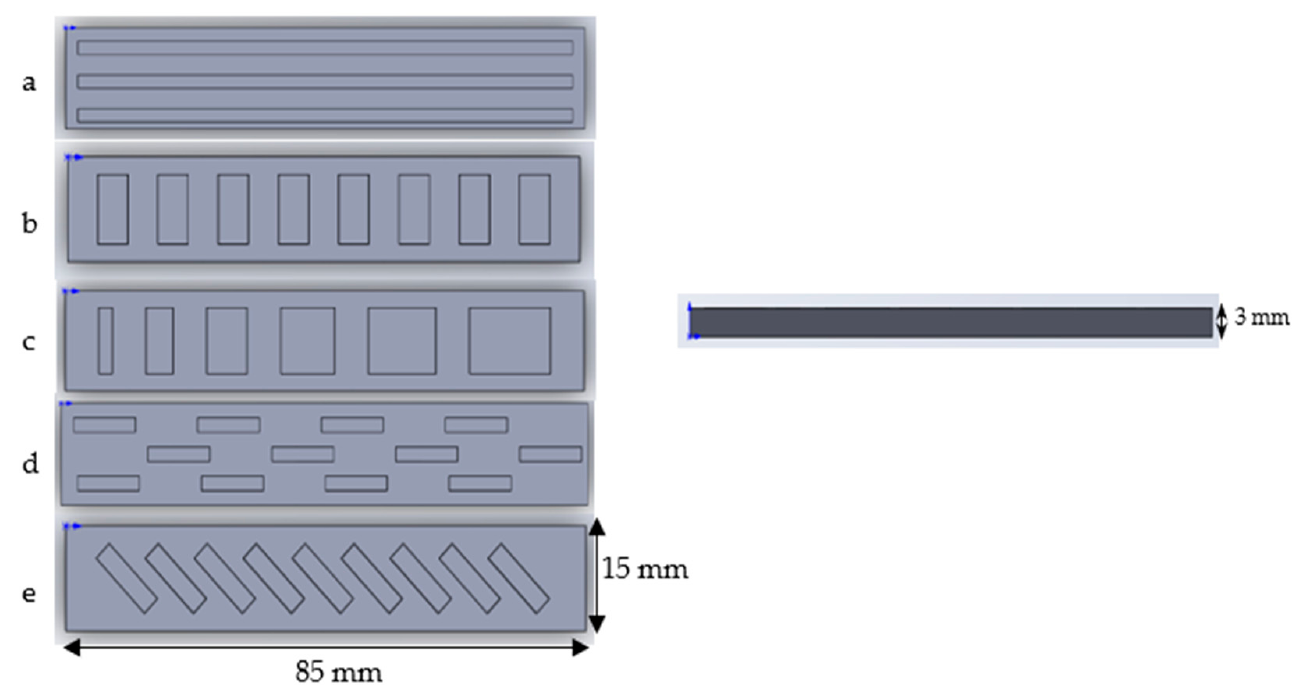
Figure 2. The design of the five types of bilayer strips. All strips in the design are 3 mm thick.